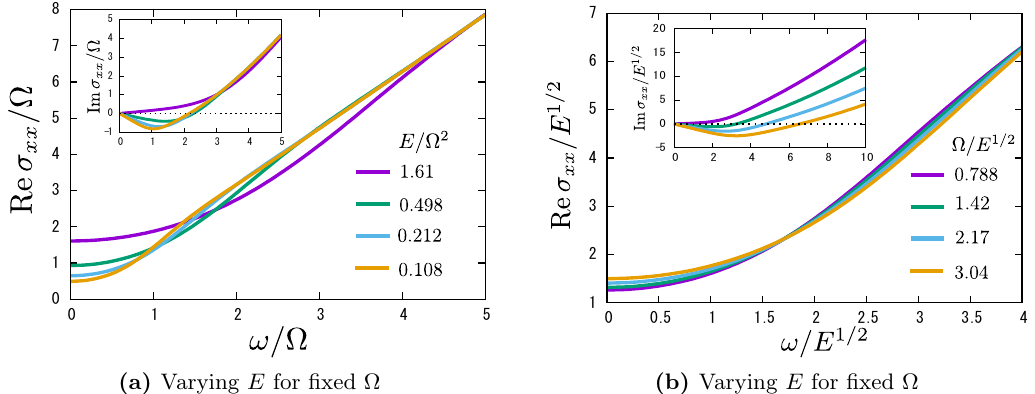
Figure 9. The optical absorption spectrum against the probe AC frequency ! . Curves in the left (right) (cid:12)gure correspond to several E ((cid:10)) for a (cid:12)xed (cid:10) ( E ). are ampli(cid:12)ed and their positions shift to higher frequency as E ((cid:10)) increases in the left (right) (cid:12)gure. This is consistent with the condensed matter calculation in refs. [27,